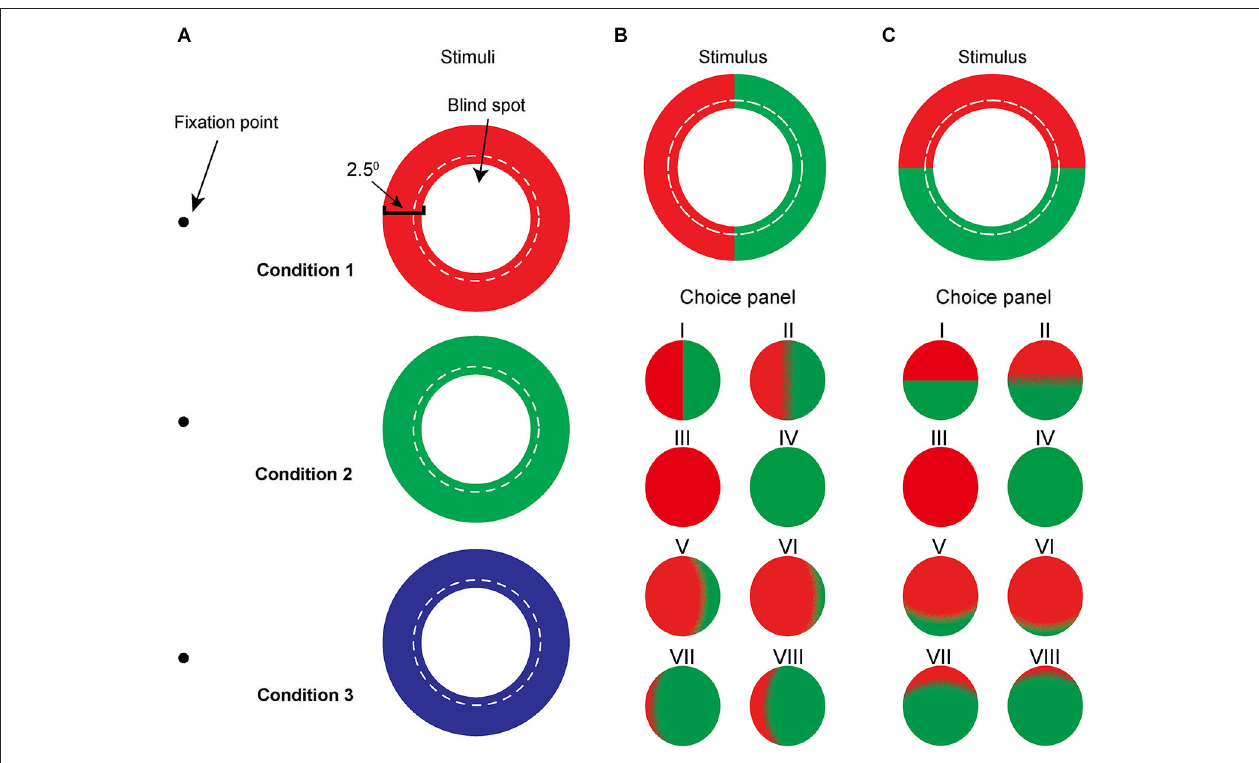
using concentric circles rather than ellipses to depict the boundary of the blind spot. (B) , (C) Bi-colored annuli of the same size were subdivided either (B) vertically, i.e. nasal/temporally or (C) horizontally, i.e. upper/lower, using, for example, red and green. Bottom panel (category labeled choice panel) is an example of the eight cartoons representing different levels of filling-in for subjects to choose